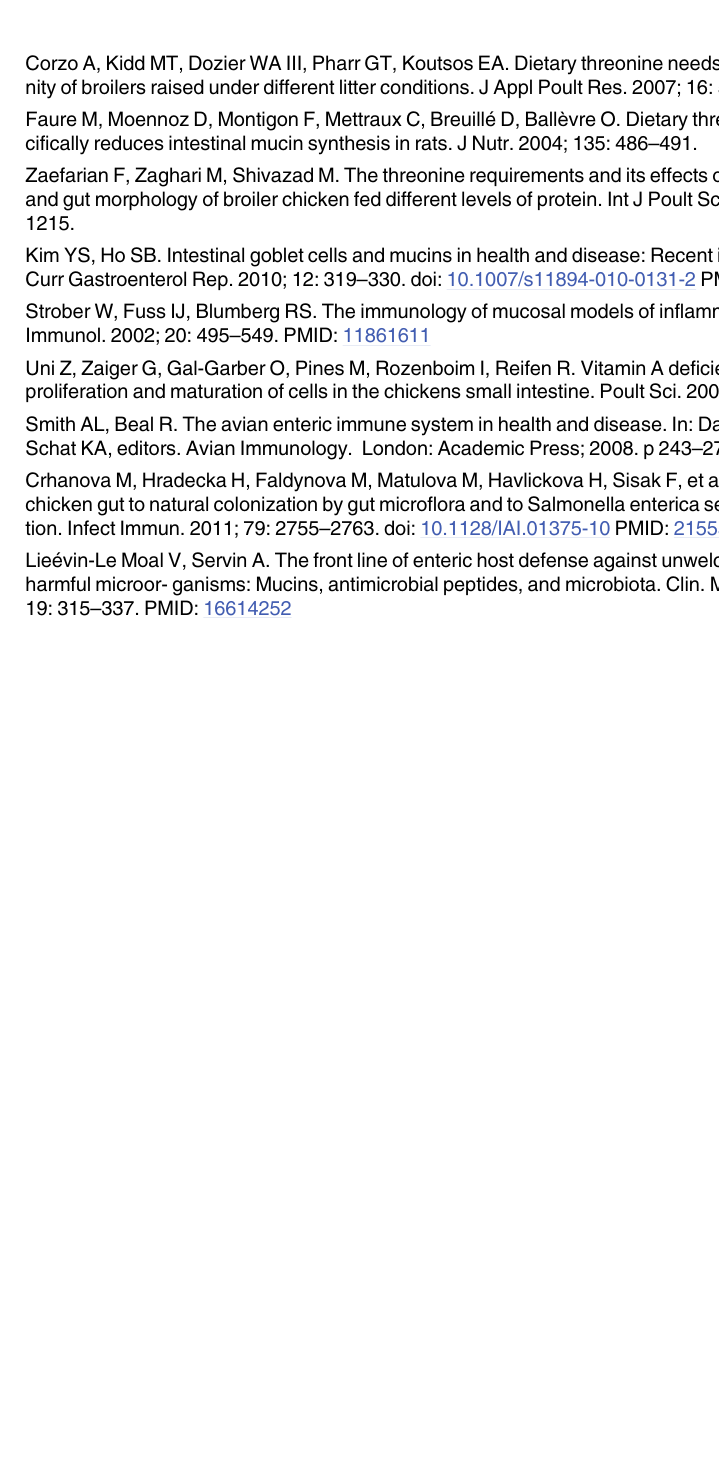
PLOS ONE | DOI:10.1371/journal.pone.0131474 July 1,